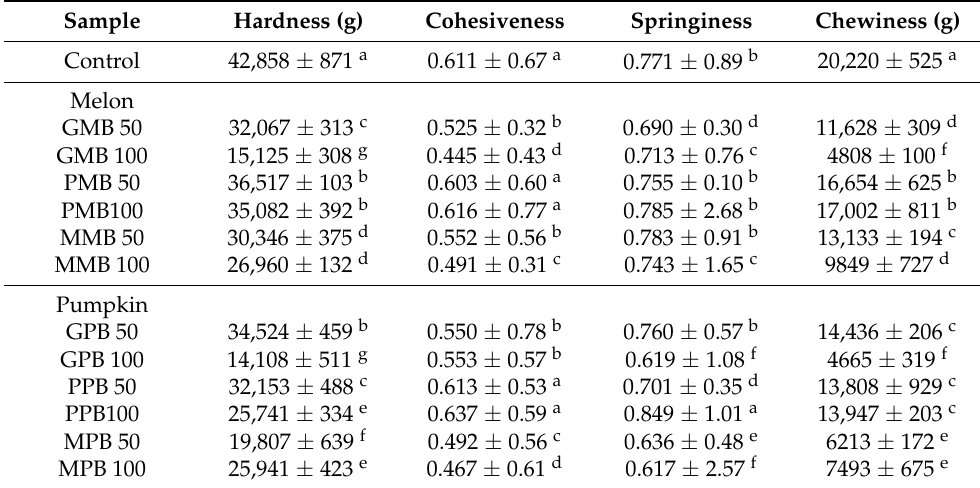
Table 4. Values for texture parameters in cooked burgers elaborated with melon and pumpkin oils. Sample Hardness (g) Cohesiveness Springiness Chewiness